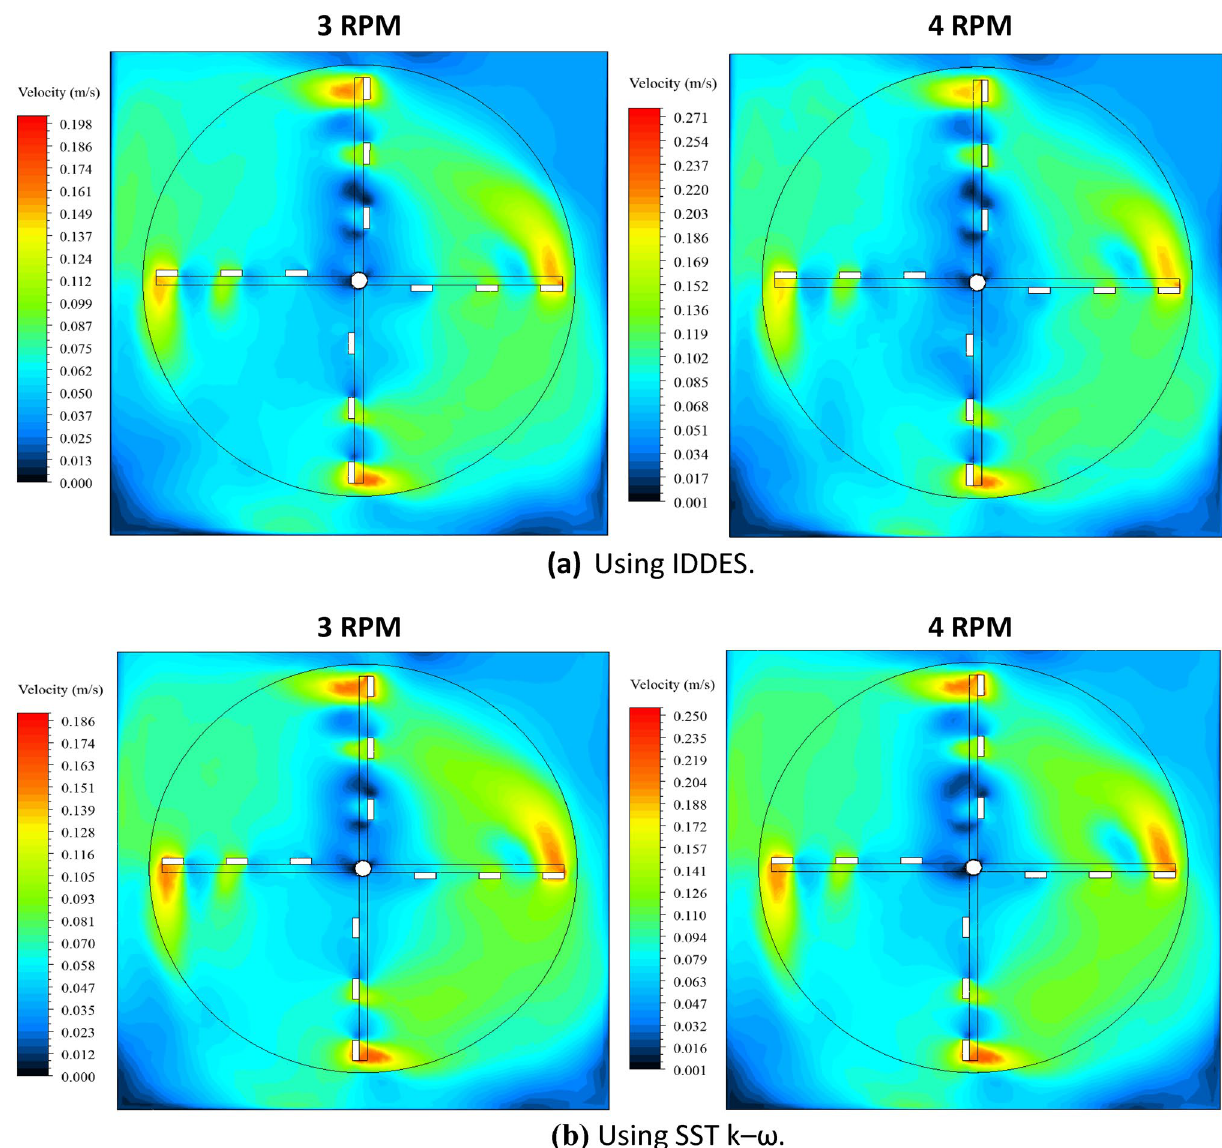
Figure 6. Time-averaged velocity contours generated using IDDES and SST k–ω with velocity contour scales higher for